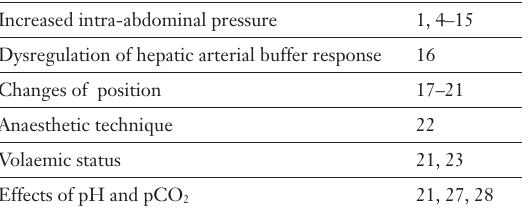
Factors influencing hepatic perfusion during